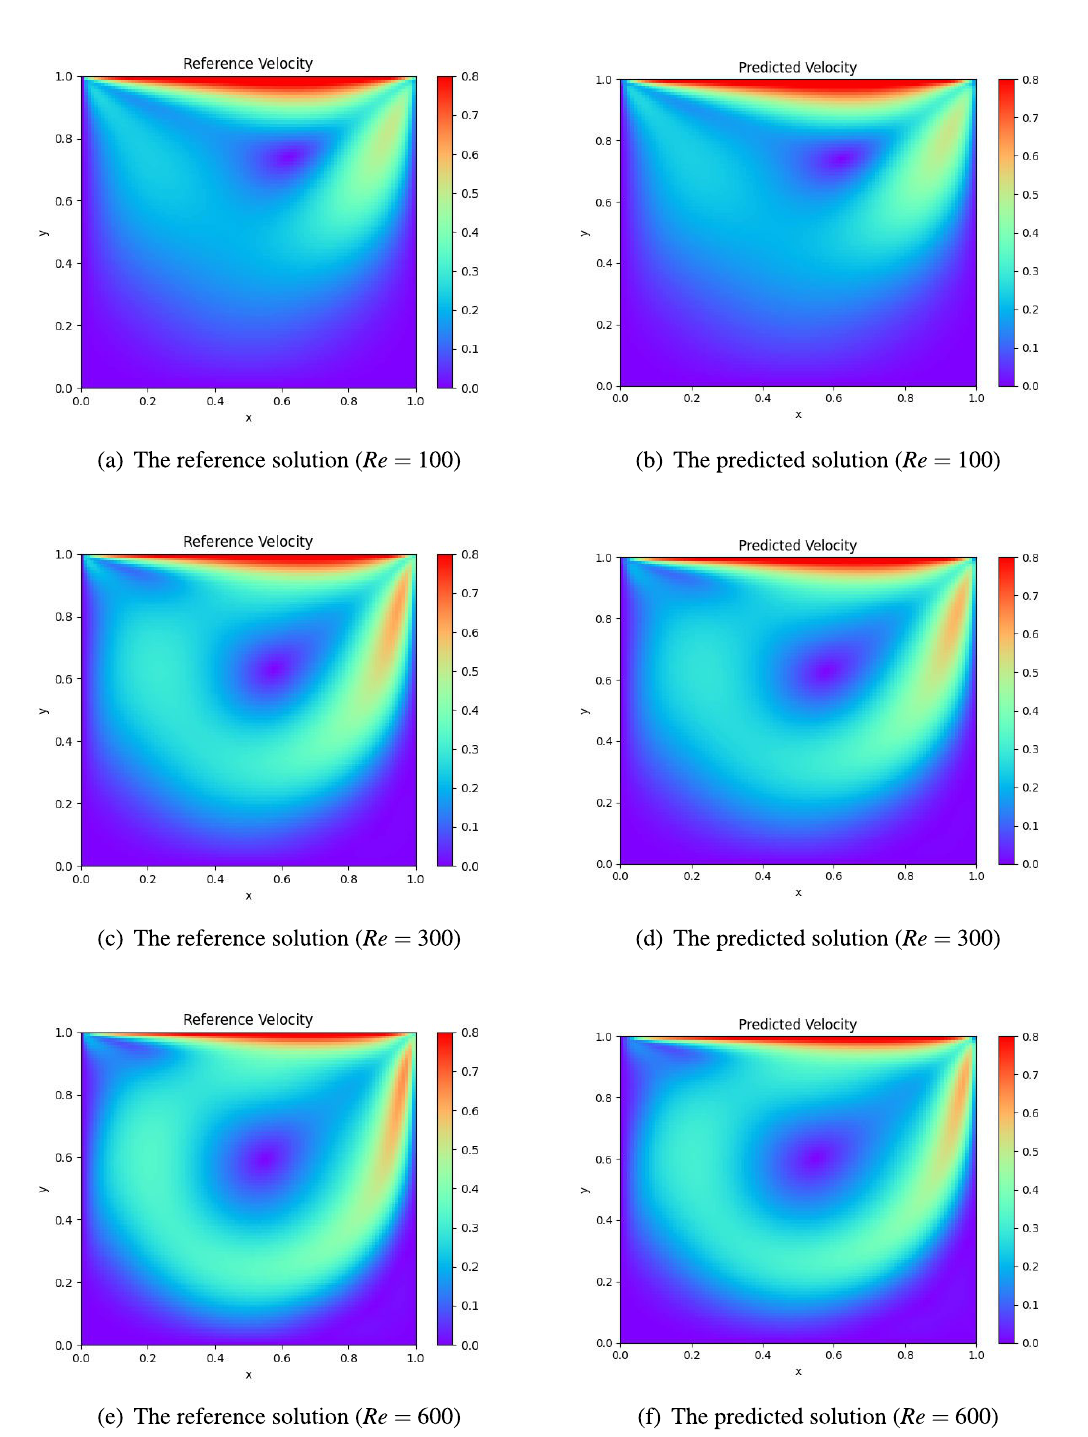
Figure 8. Lid-driven cavity flow: comparison of the reference solution with the predicted solution given by